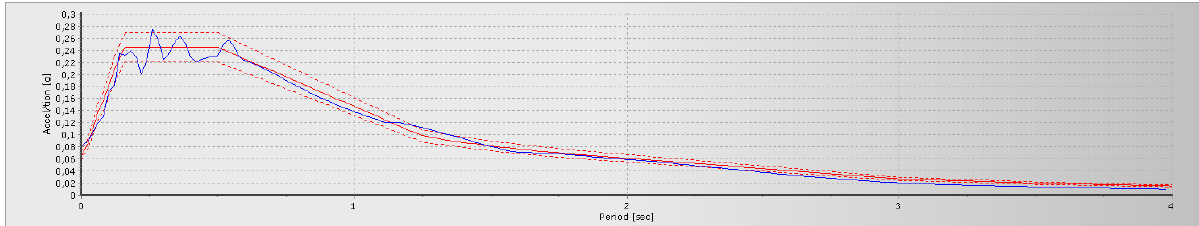
Figure 9. Comparison of the acceleration.